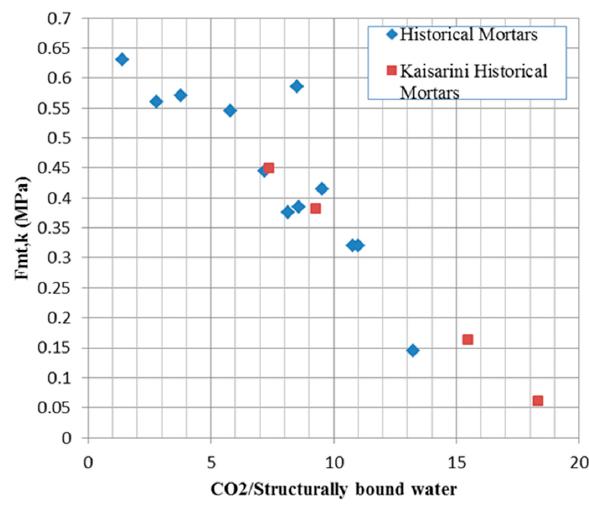
Figure 7. Grouping of the Kaisariani mortars according to thermal analysis results.